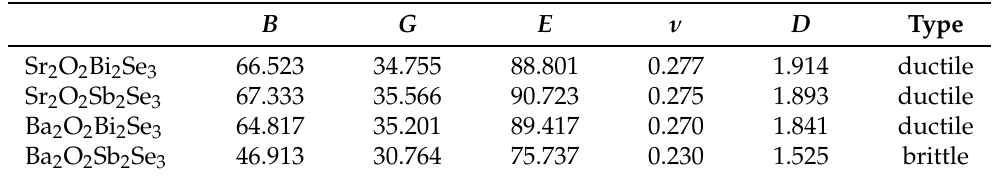
Table 3. The calculated polycrystalline elastic constants ( B (GPa), G (GPa), and E (GPa)), and Poisson’s ratio ν and Pugh’s ratio ( D ) for A 2 O 2 B 2 Se 3 (A = Sr, Ba and B = Bi, Sb) materials. B G E ν D